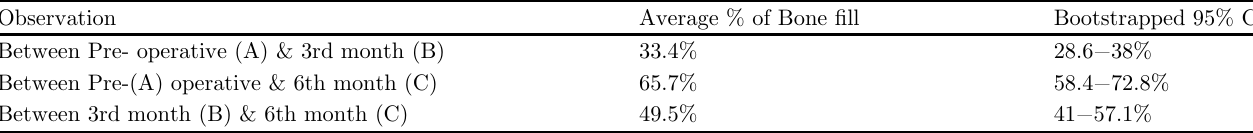
Table 1. Average percentage bone fi ll at the end of 3rd and 6th month. Observation